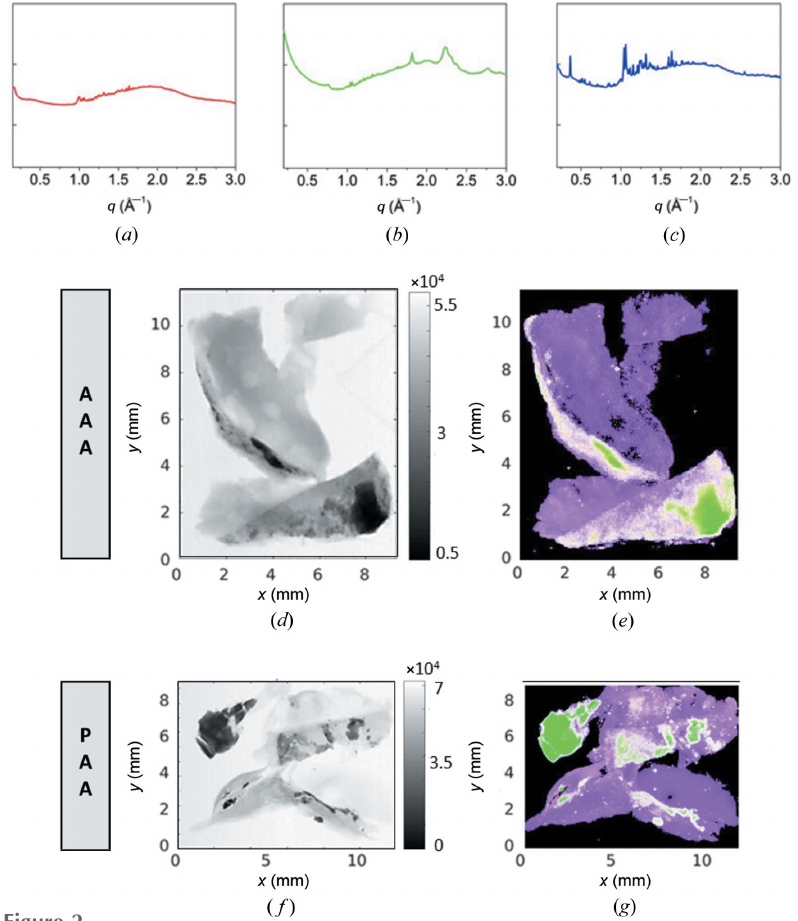
Figure 2 XTM and m WAXS images. Representative m WAXS profiles selected using signal classification followed by canonical-correlation-analysis-based integration: ( a ) amorphous material, ( b ) nanocrystal and ( c ) microcrystal. ( d ), ( f ) XTM images and ( e ), ( g ) m WAXS RGB color maps for the AAA (middle row) and PAA (lower row) tissues. At each point of the RGB color map, the value of the red, green and blue color channel corresponds to the correlation with the representative signal shown in ( a ), ( b ) and ( c